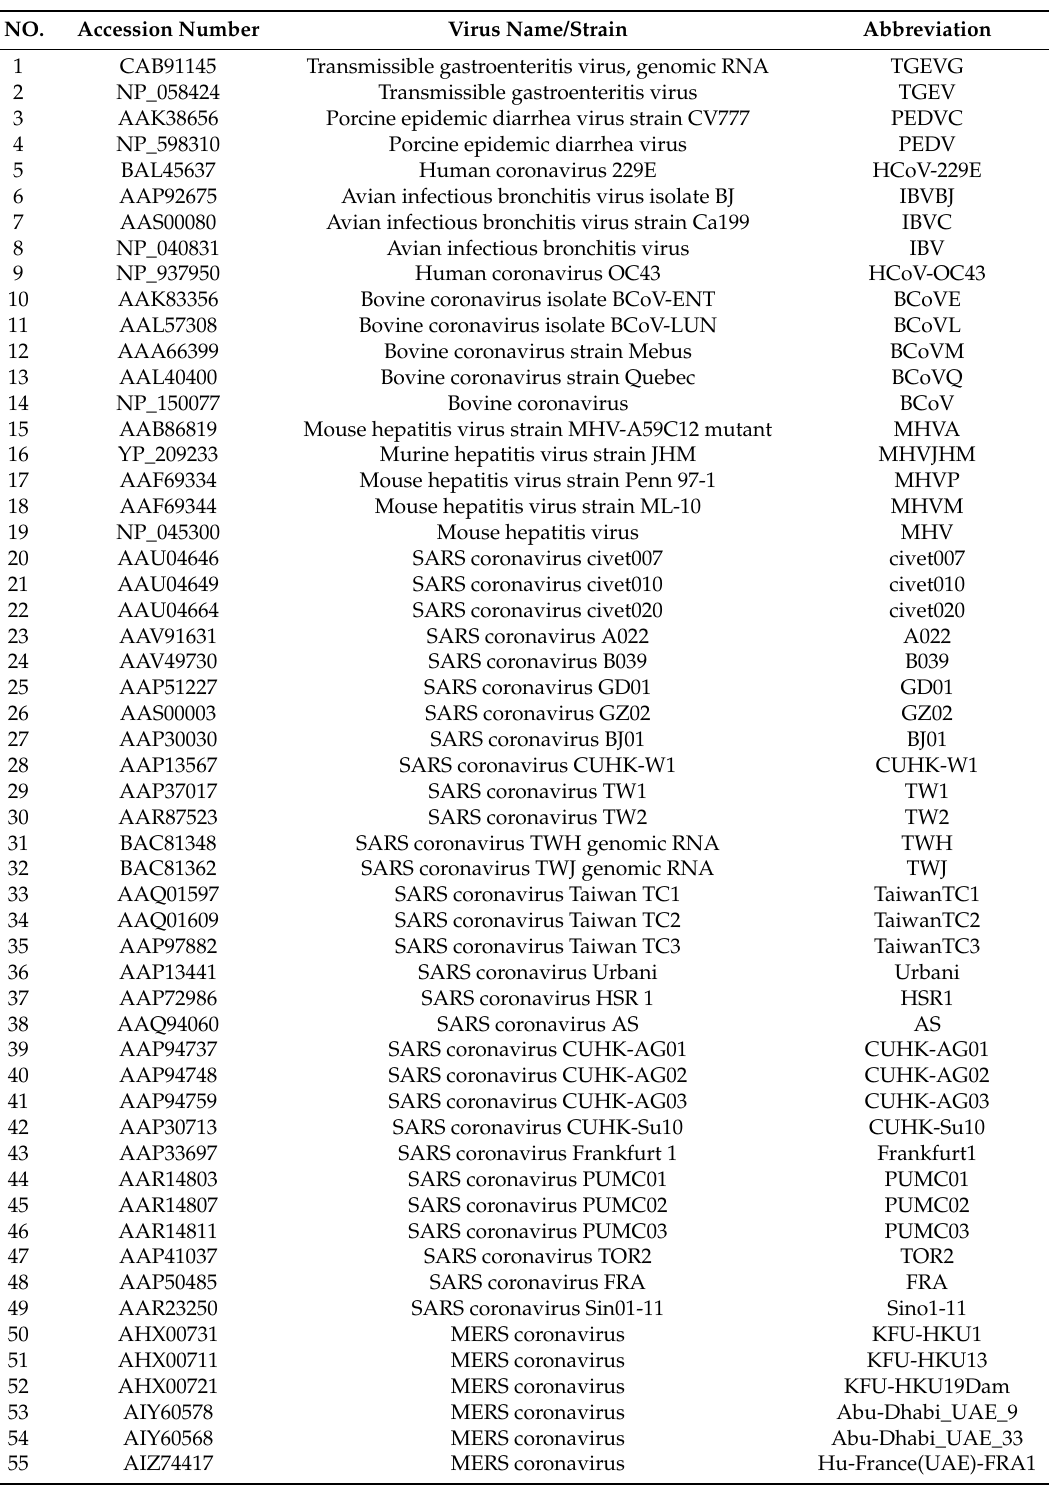
Table 5. The accession number, name and abbreviation for 72 coronavirus spike